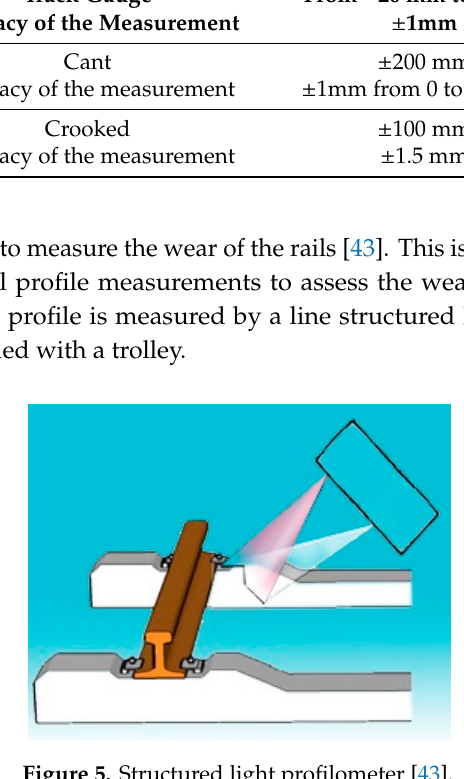
Figure 5. Structured light profilometer [43].